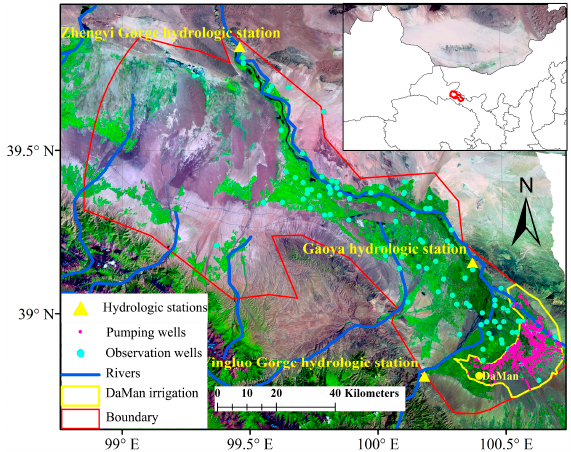
Figure 1. Location and map of the middle reaches of the Heihe River Basin and the Daman irrigation district.